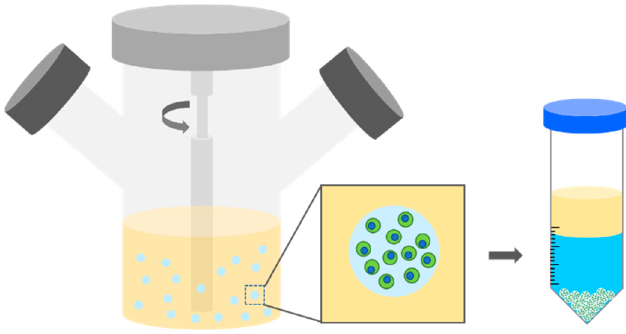
Figure 6. Stem cell encapsulation by an emulsion method.